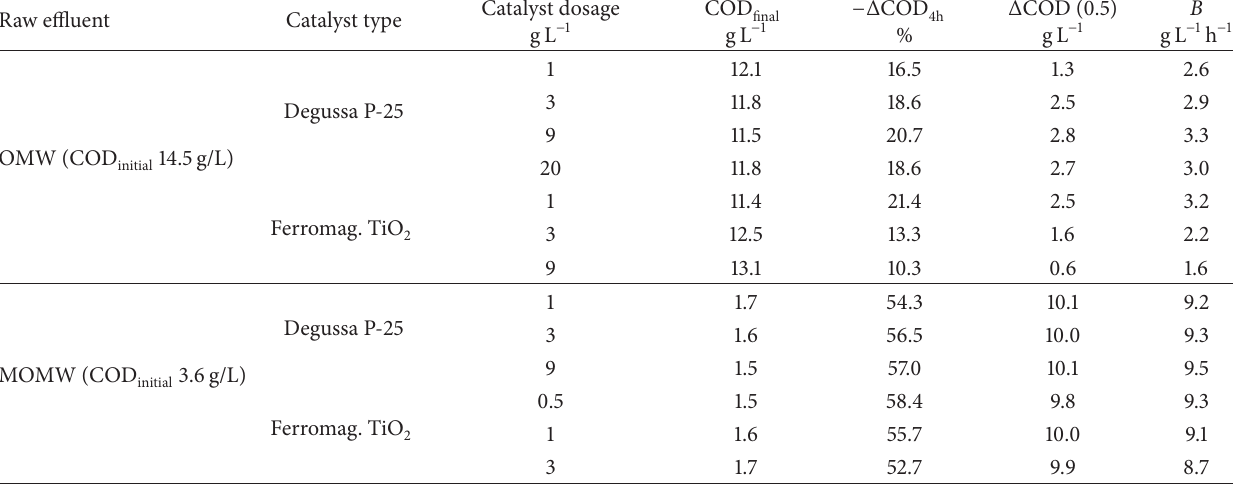
photocatalysis. 2